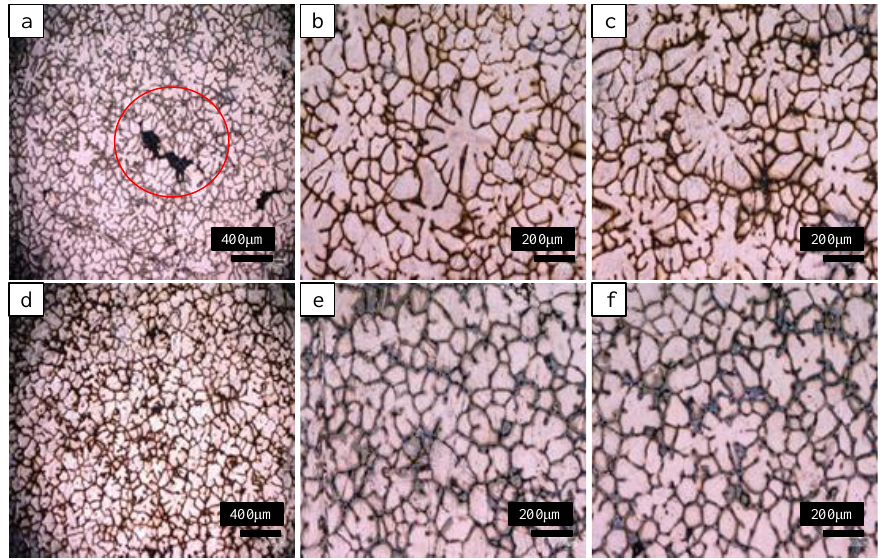
Figure 4. Grain structure of conventional and ultrasonic ingots: ( a ) edge of conventional ingot; ( b ) 1/2 radius of conventional ingot; ( c ) center of conventional ingot; ( d ) edge of ultrasonic ingot; ( e ) 1/2 radius of ultrasonic ingot; ( f ) center of ultrasonic ingot.